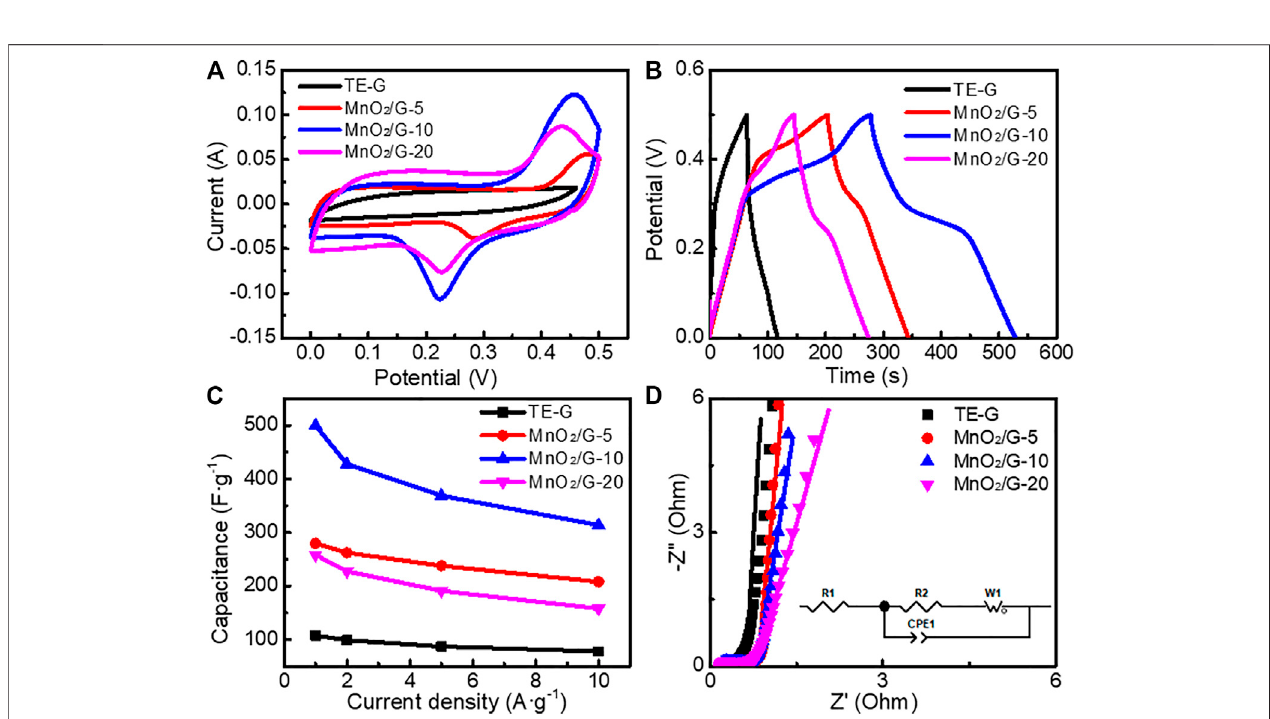
FIGURE 7 | Electrochemical performance of TE-G and different MnO 2 /G composites in a three-electrode cell (A) CV curves tested at 20 mV s − 1 (B) the charge- discharge curves tested at 1 A g − 1 (C) the speci fi c capacitance (D) EIS plots, equivalent circuit and fi tting curves (solid line).